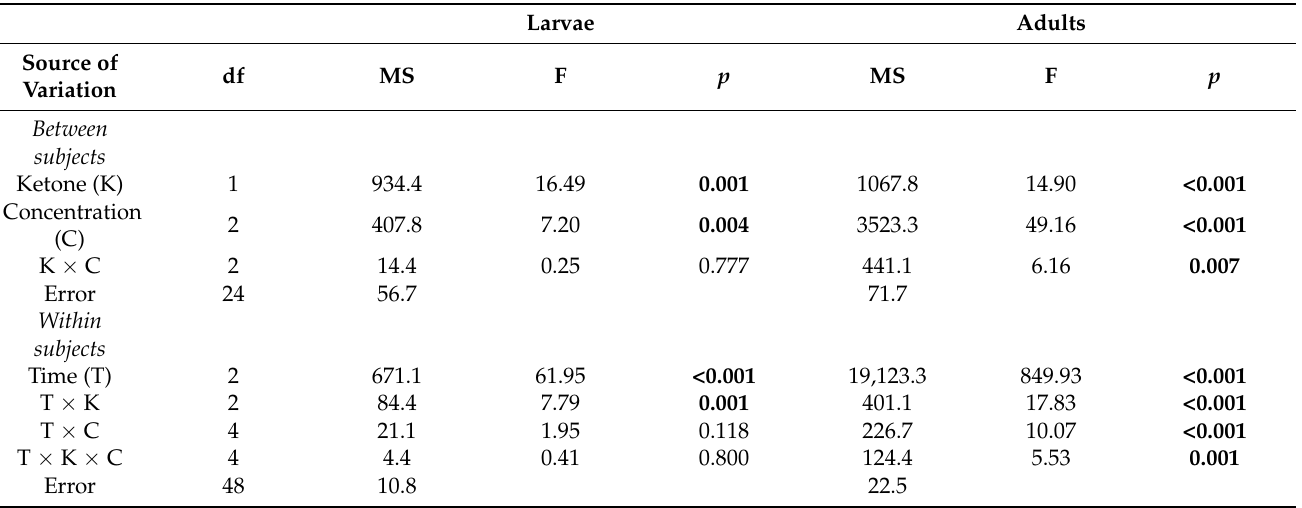
Table 1. Repeated measures ANOVA for the leaf damage during the exposure time in CPB larvae and adults exposed to ketone monoterpenes (pure camphor or the thujone-camphor mixture) at different concentrations. Significant effects are given in bold. Larvae